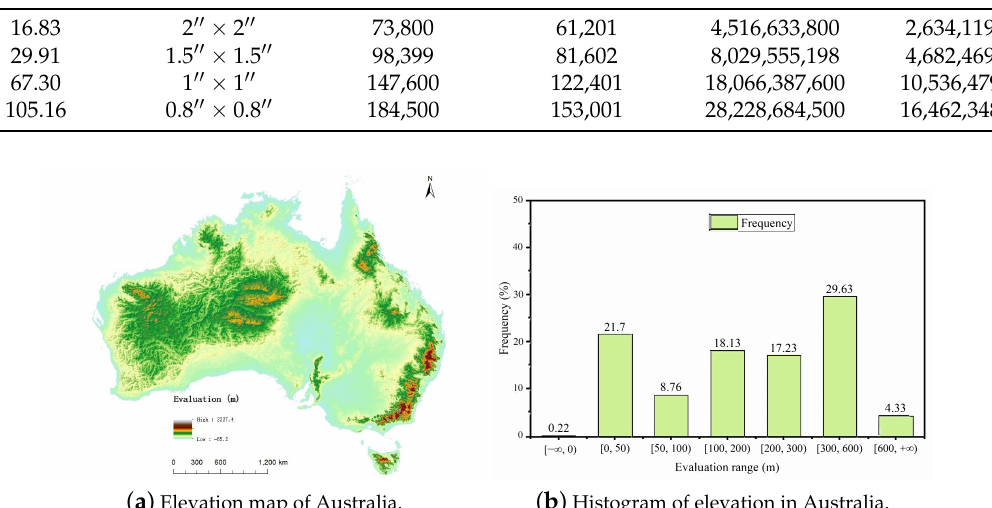
( b ) Histogram of elevation in Australia.